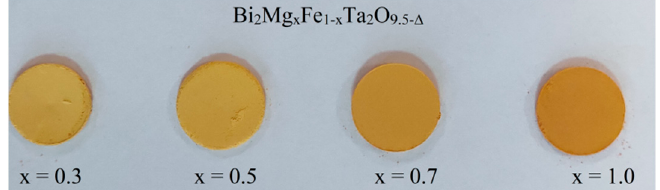
Figure 3. Photographs of the Bi 2 Mg x Fe 1-x Ta 2 O 9.5- Δ (x = 0, 0.3, 0.5, 0.7)